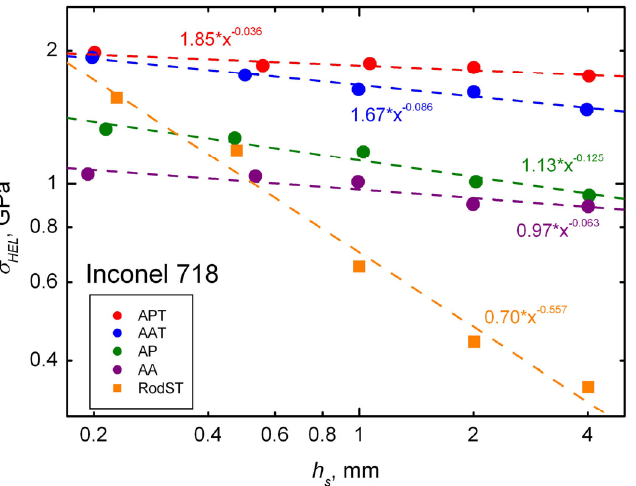
Figure 5. Dependences of the Hugoniot elastic limit on the thickness of Inconel 738 cast alloy samples and samples manufactured by DLD method.